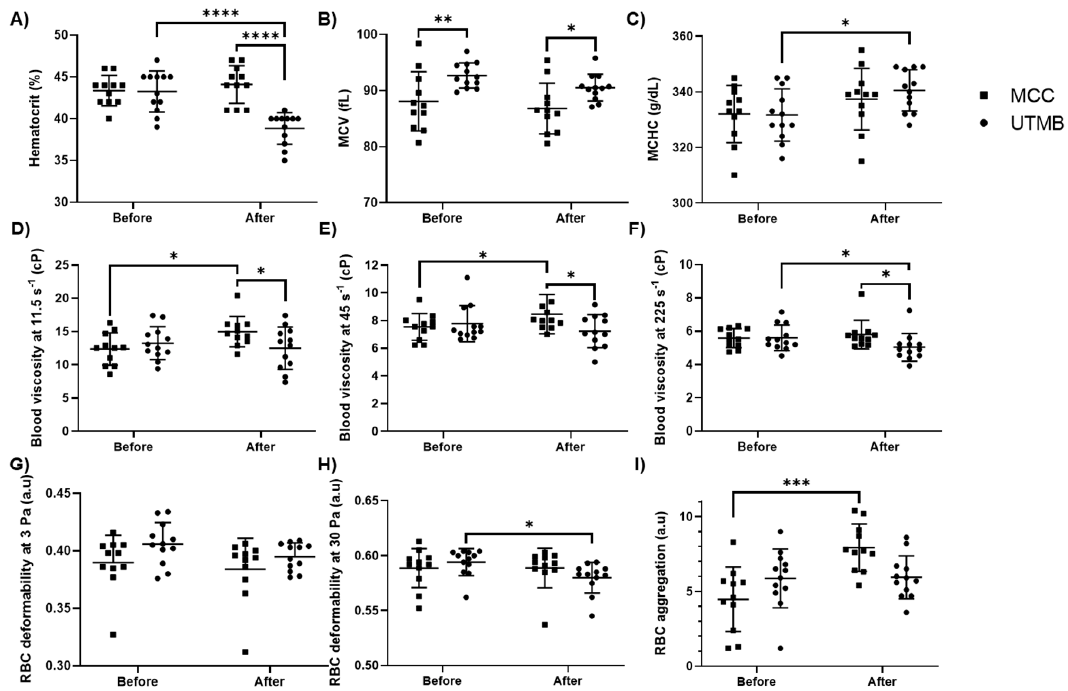
Figure 1. Evolution of hematological and hemorheological parameters before and after Ultra-Trail du Mont Blanc (UTMB) ( n = 12) or Martigny–Combes à Chamonix (MCC) ( n = 11) race. ( A ) Hematocrit (Hct); ( B ) Mean corpuscular volume (MCV); ( C ) Mean corpuscular hemoglobin concentration (MCHC); Blood viscosity measured at ( D ) 11.5 s − 1 ( E ) 45 s − 1 , ( F ) 225 s − 1 ; red blood cell (RBC) deformability measured at ( G ) 3 Pa, ( H ) 30 Pa and ( I ) RBC aggregation. Values are represented as means ± SD. Statistical difference: * p < 0.05, ** p < 0.01, *** p < 0.001, **** p < 0.0001.